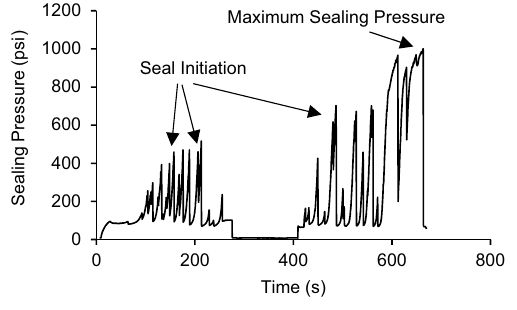
Fig. 2 Pressure vs. time plot obtained from a test using 30 ppb G and SCC mixed with 14.5 ppg OBF using 1000-micron fracture width. The maximum pressure would be recorded as the sealing